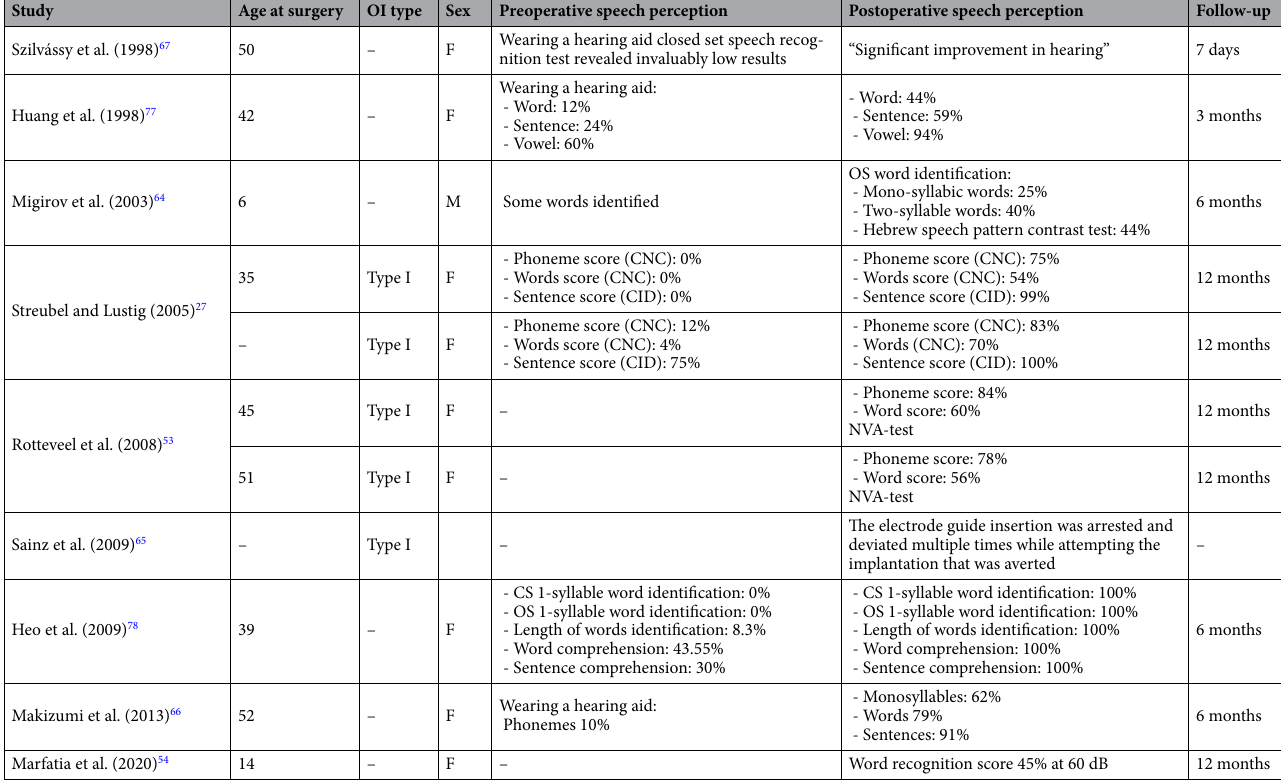
Table 6. Short-term (< 12 months) outcomes of cochlear implantations in individuals with osteogenesis imperfecta (OI). No sufficient data is represented with a line (–). F indicates female, M male, OS open-set,